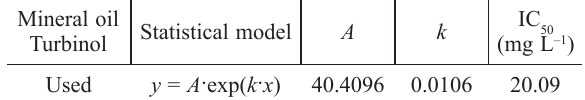
Table 7 – Statistical model of the calculation of IC growth inhibition of Sinapis alba root Mineral oil